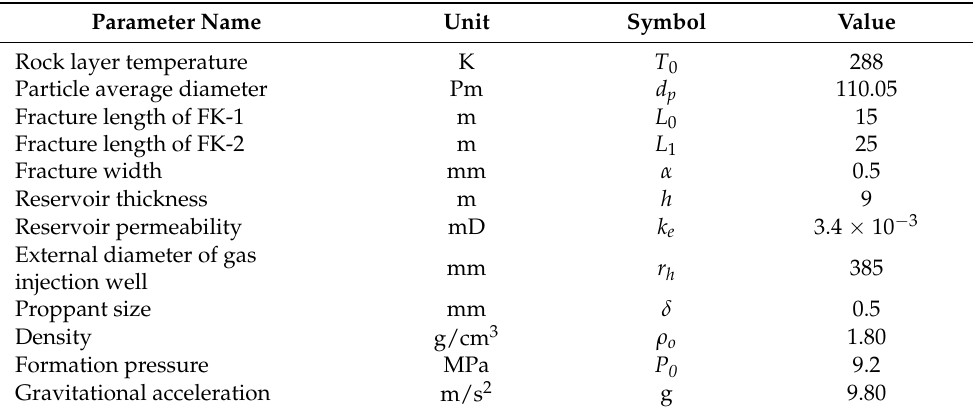
Table 6. Calculation tables of oil